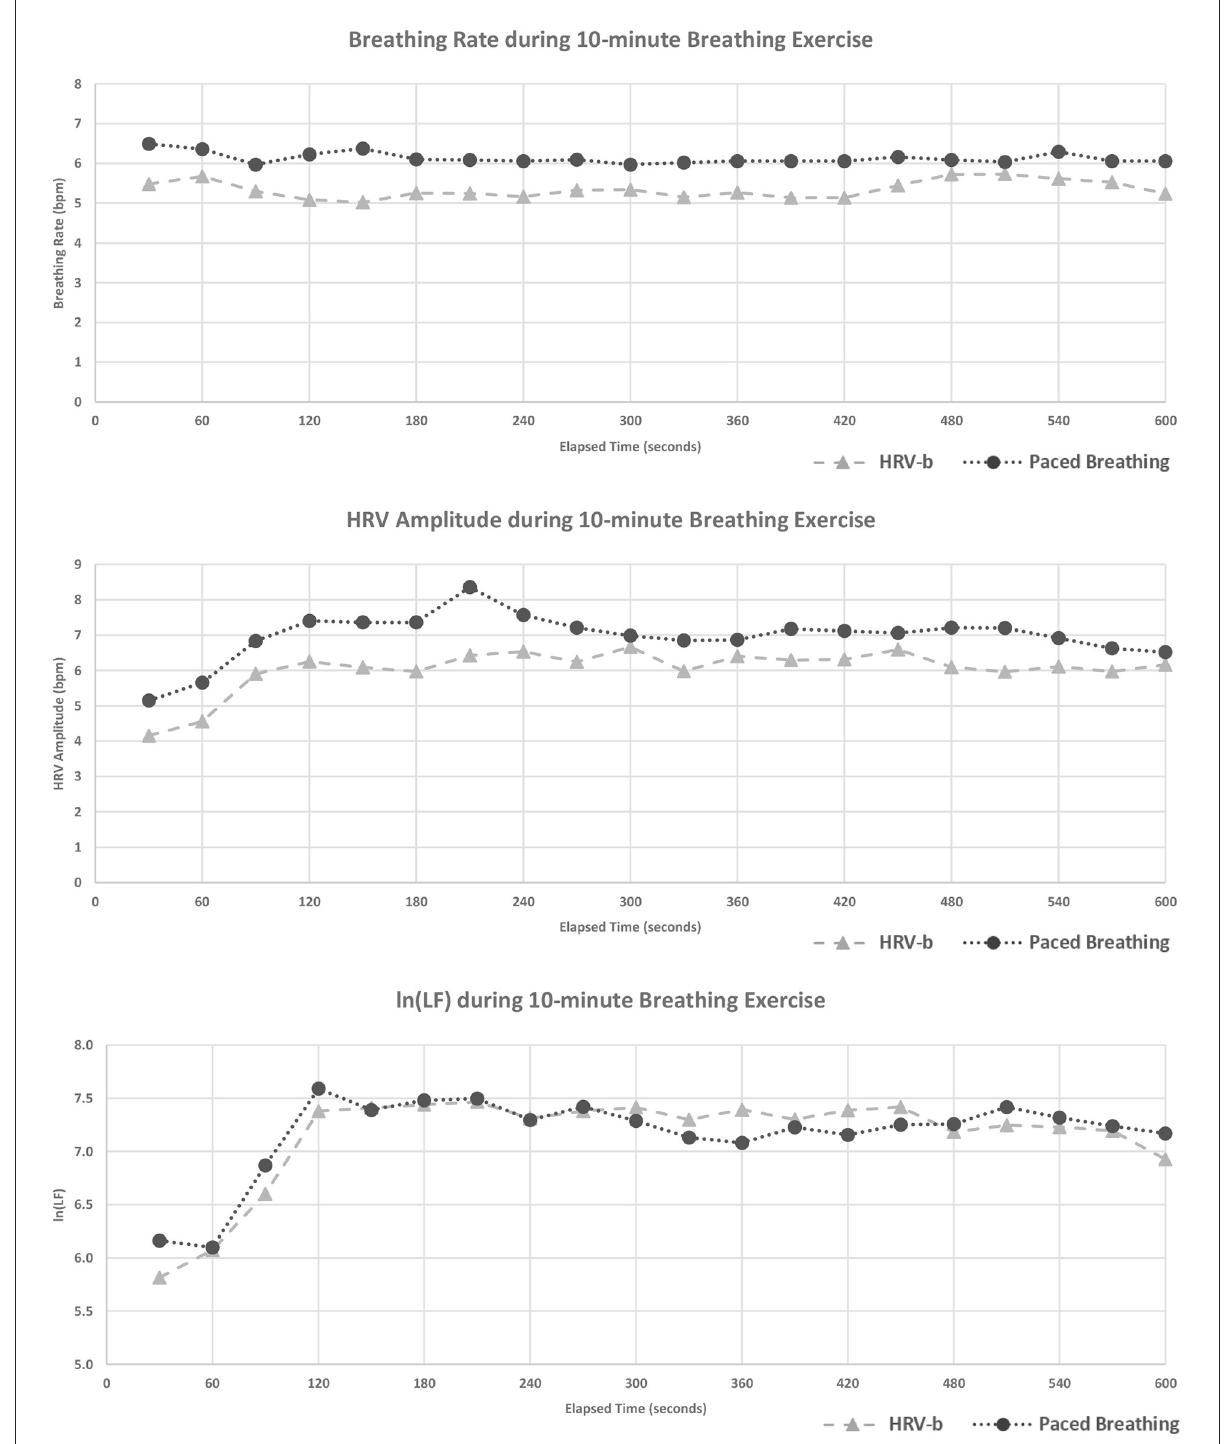
FIGURE9 Profiles of breathing rate (top) , hrv amplitude (middle) , and ln(LF) (bottom) during the 10-min guided breathing exercise. Plotted values indicate the end of each 30-s computation window. Data is broken down by exercise protocol ( Paced Breathing , black dotted lines; HRV-b , gray dashed lines). Visual inspection suggests that reductions in breathing rate and increases in HRV scores occurred in a similar fashion with both exercise